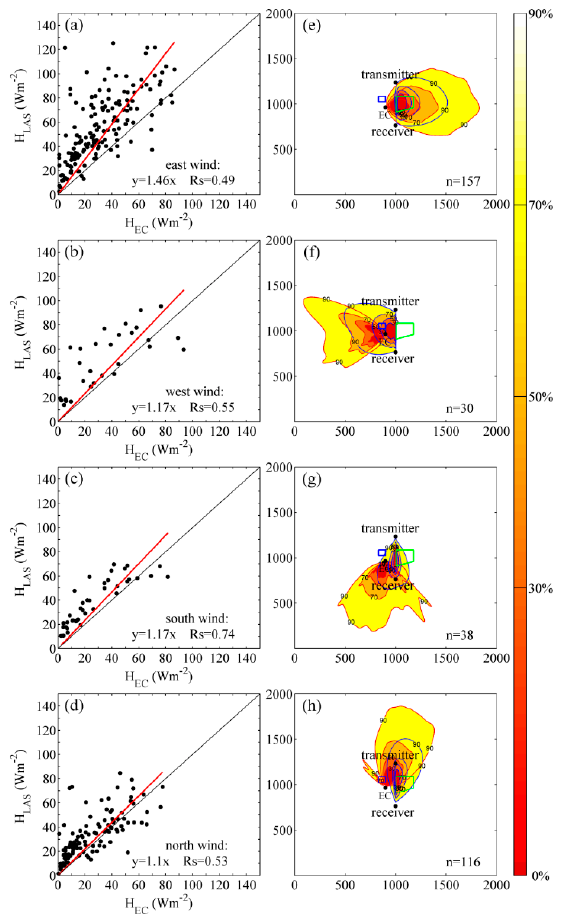
Figure 8. Relationship between LAS-derived and EC-derived sensible heat fluxes under ( a ) east wind, ( b ) west wind, ( c ) south wind and ( d ) north wind conditions is shown in the left panels. The slopes and determination coefficients are also shown in the picture. The regression lines are plotted in red. The corresponding average footprints for LAS and EC under ( e ) east wind, ( f ) west wind, ( g ) south wind and ( h ) north wind conditions are shown in the right panels. The blue rectangle represents the grove, and the green trapezoid represents the mulberry seedling field. The numbers ( n ) of data points are also given in the figure. Table 1. Comparison of the LAS and EC measured factors derived for sensible heat fluxes under unstable conditions. The LAS-EC regression slope (k), determination coefficient (Rs), mean square error (RMSE), mean air density ( ρ ), mean friction velocity ( u ∗ ), mean temperature scale parameter ( T ∗ ) are shown in this table.